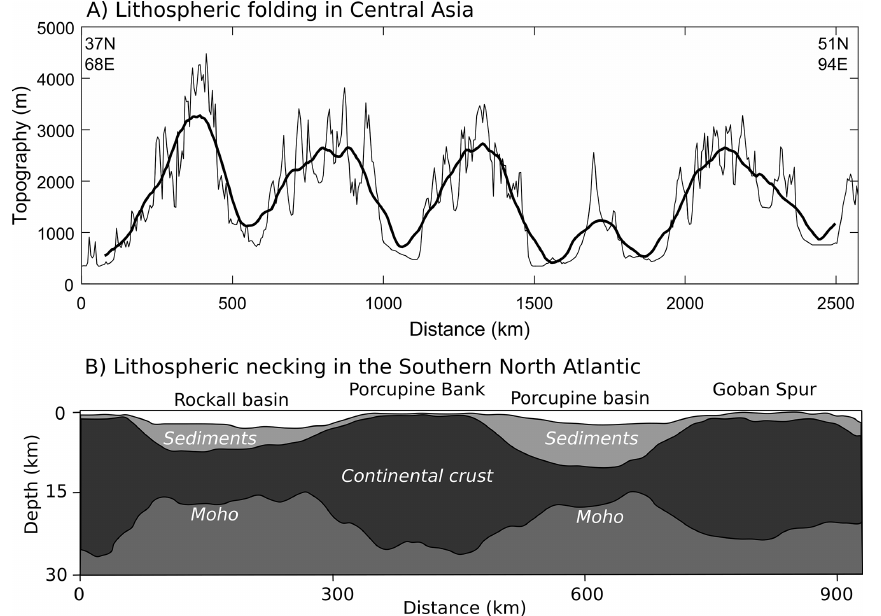
Figure 7. Lithospheric folding and necking. (a) Topography across Central Asia with data from Geocontext-Profiler. The thin solid line is the original data and the thick solid line shows the running average topography within a 150km wide window. The fold-like topography has been interpreted as the result of lithospheric folding (Burov et al., 1993). (a) Crustal geometry across the Rockall and Porcupine basins modified after Mohn et al. (2014) and Welford et al. (2012). The thinned continental crust has been interpreted to be the result of necking.